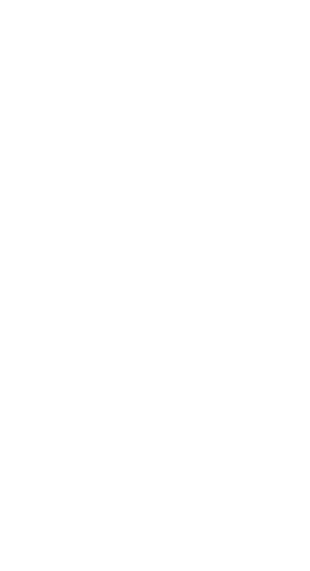
Table 2. Anthropometric characteristics, body composition characteristics and malnutrition preva- lence among adolescent